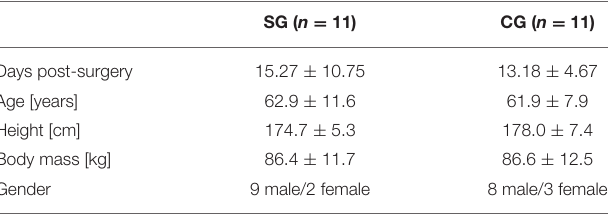
TABLE 1 | Basic characteristics of the sonification group (SG) and control group (CG).